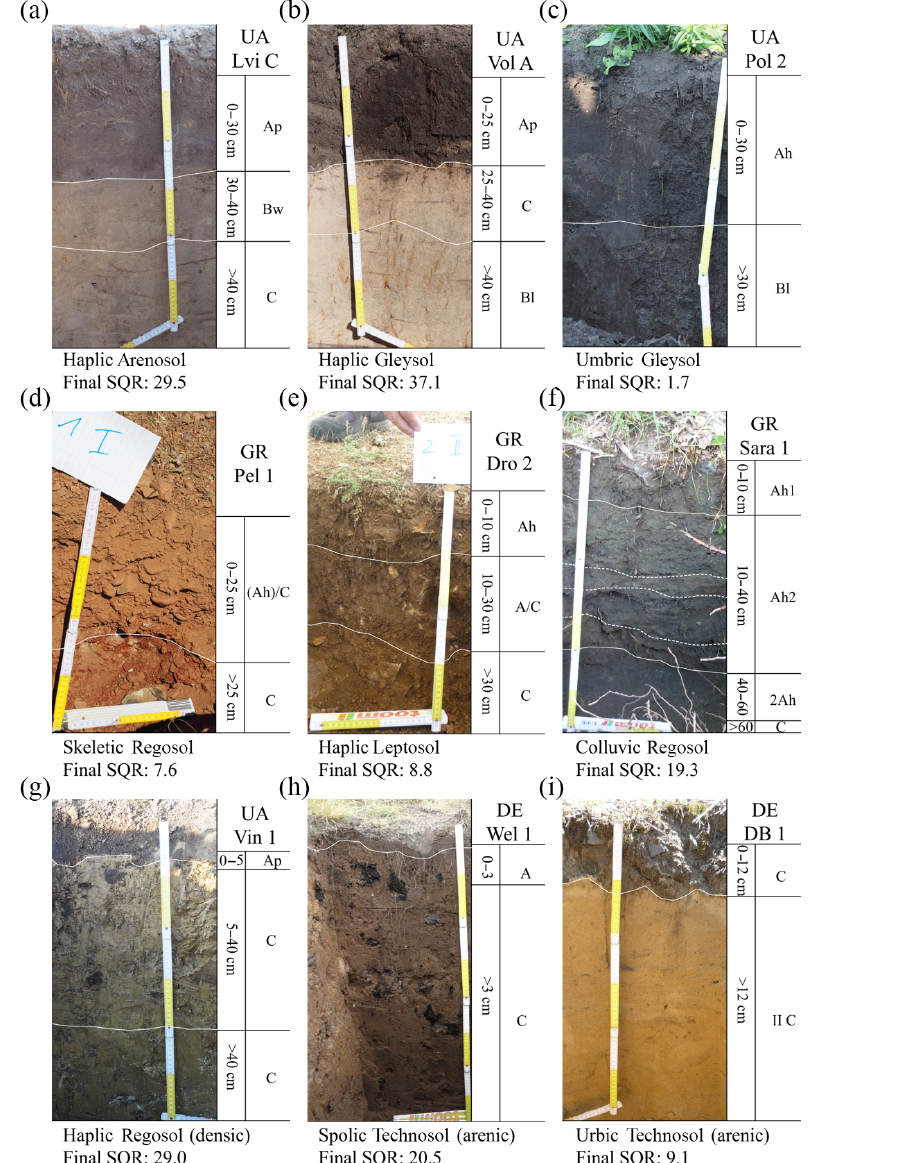
Figure 3. Soil profiles of marginal lands: (a, b, c) abandoned arable lands in Ukraine (UA); (d, e, f) mountain soil profiles in Greece (GR); (g, h, i) anthropogenically degraded soils in Ukraine (UA) and Germany (DE).